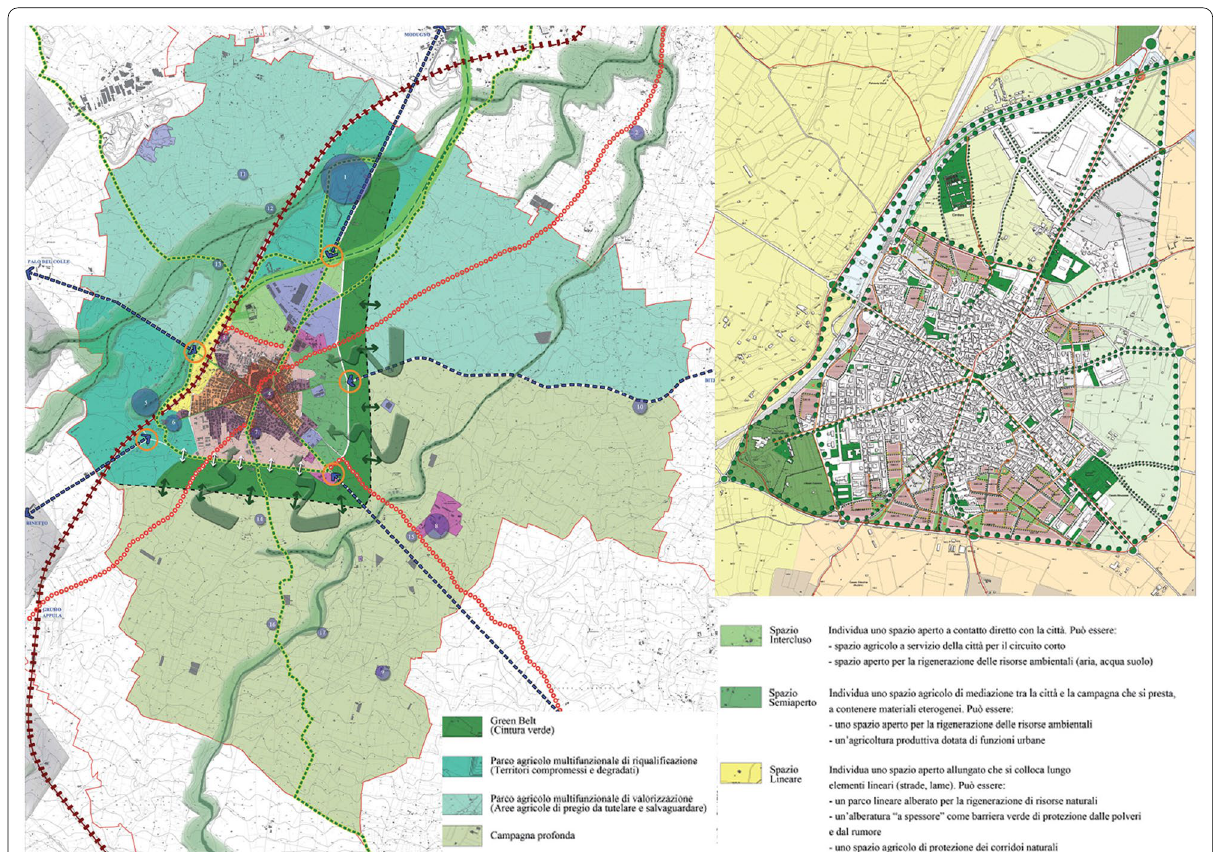
Fig. 8 The City-Country Pact strategy. The image on the left shows the components of the Pact. The strategy identifies a green belt between the deep countryside (south and east), the multifunctional agricultural park for the valorisation of high-quality crops (north and east) and the multifunctional agricultural park for the redevelopment of industrial areas (west). On the right, the master plan shows the articulation of the ristretto area through new settlements and new green spaces relating to the peri-urban green belt. Source: Municipality of Bitetto, extracts from tables A3 (original content scale 1:10,000, north–south oriented) and PP2 (original content scale 1:3000, north–south oriented) of the Adaptation of the Municipal Plan to the PPTR